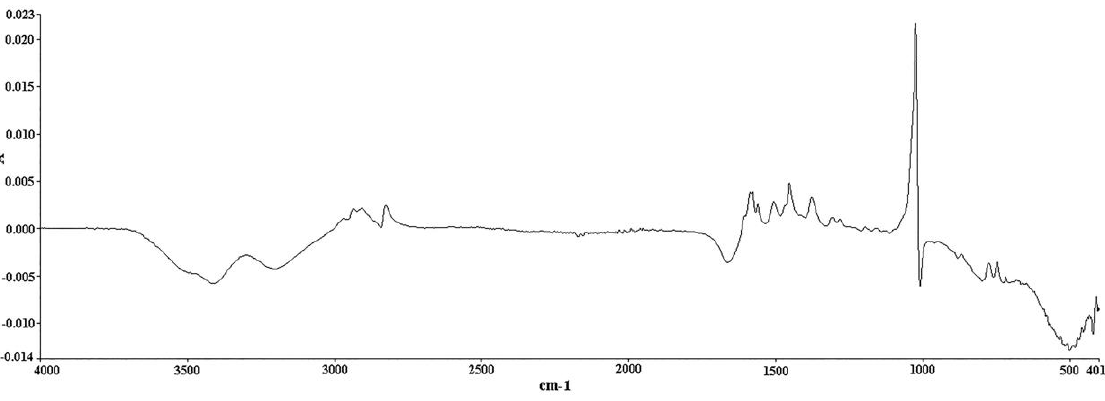
Figure 8. ATR FT-IR spectrum of DS methanolic solution (20 g/L) after taking a methanol spectrum as background spectrum (abscissa units: wavenumber (cm − 1 ); ordinate units: absorbance).